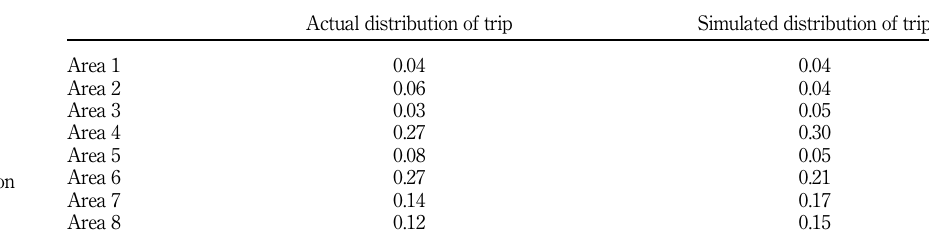
Table 5. Effort distribution actual versus